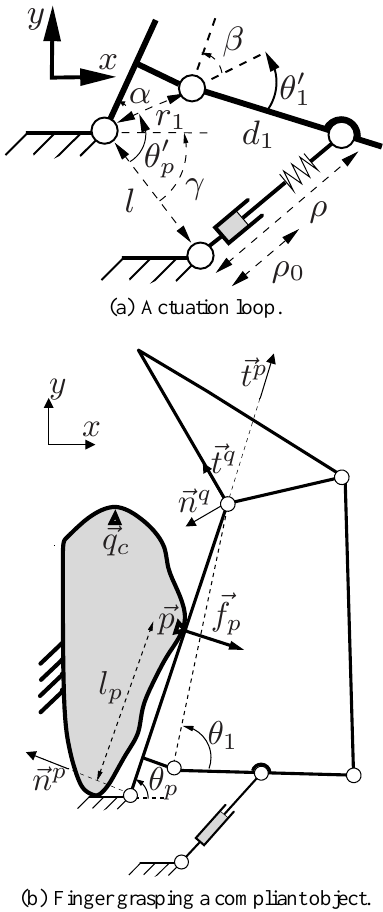
Figure 3. 2-DOF compliant underactuated